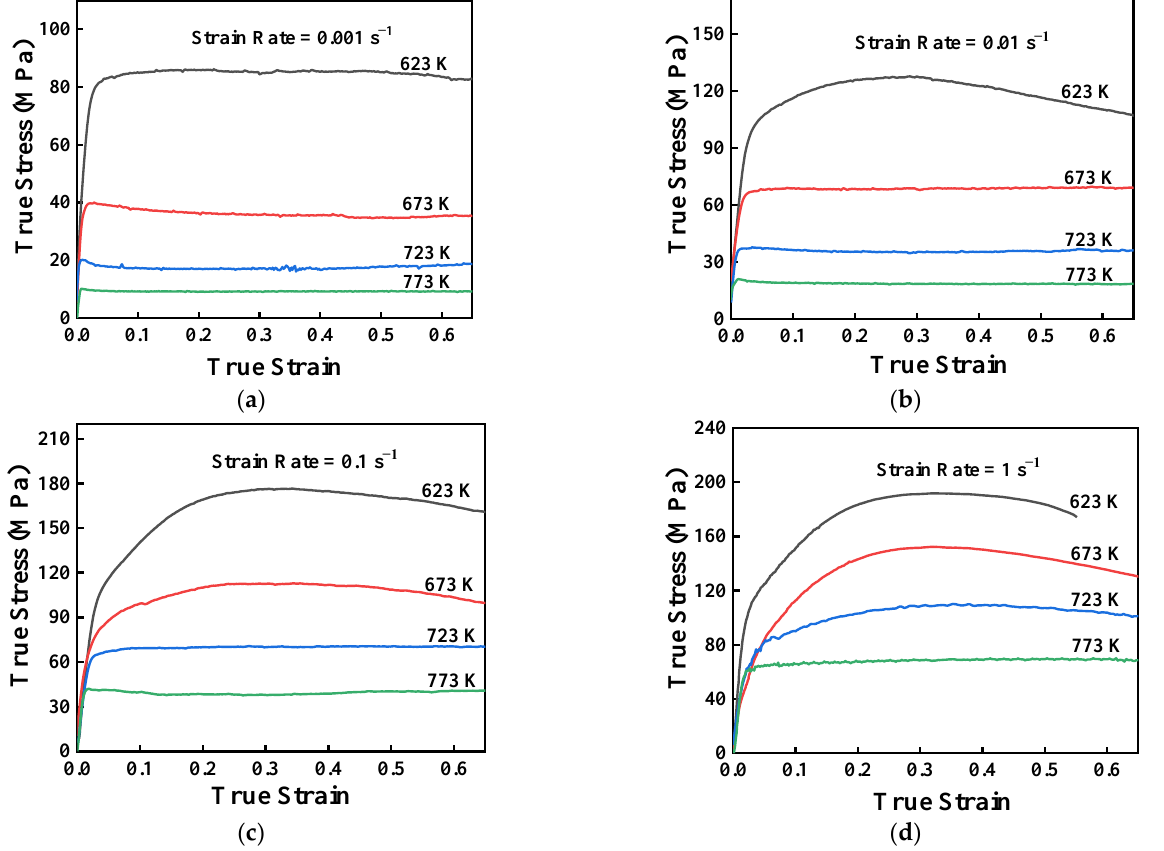
Figure 2. True strain-stress curves of GW103K Mg alloy under different strain rates: ( a ) 0.001 s −1 ; ( b ) 0.01 s −1 ; ( c ) 0.1 s −1 ; and ( d ) 1 s −1 .